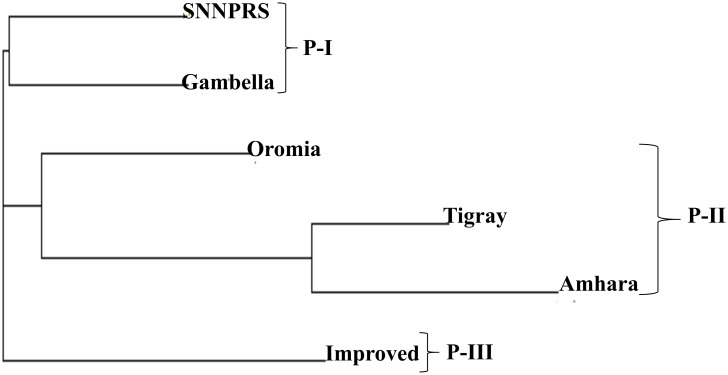
Neighbor joining tree among five different regions of Ethiopia and introduced improved cultivars based on pairwise FST.